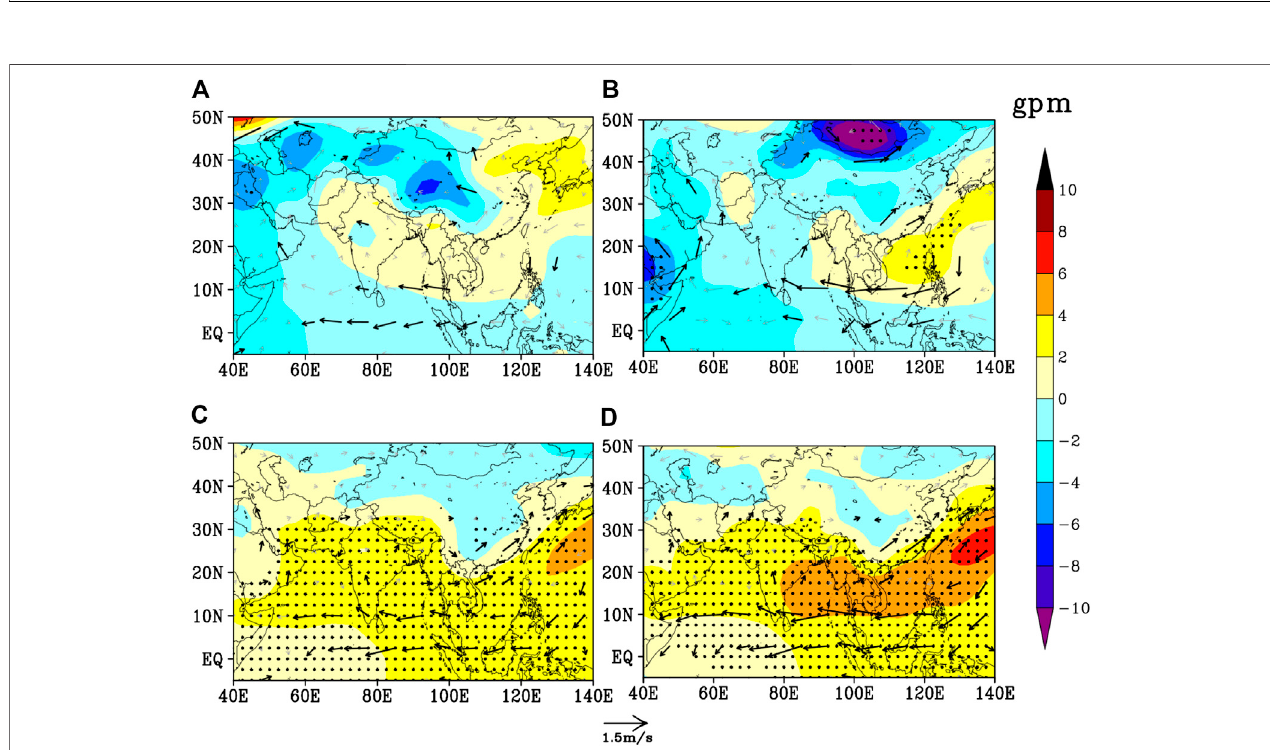
FIGURE 10 | Same as Figure 9 , but for the variables at 850 hPa.